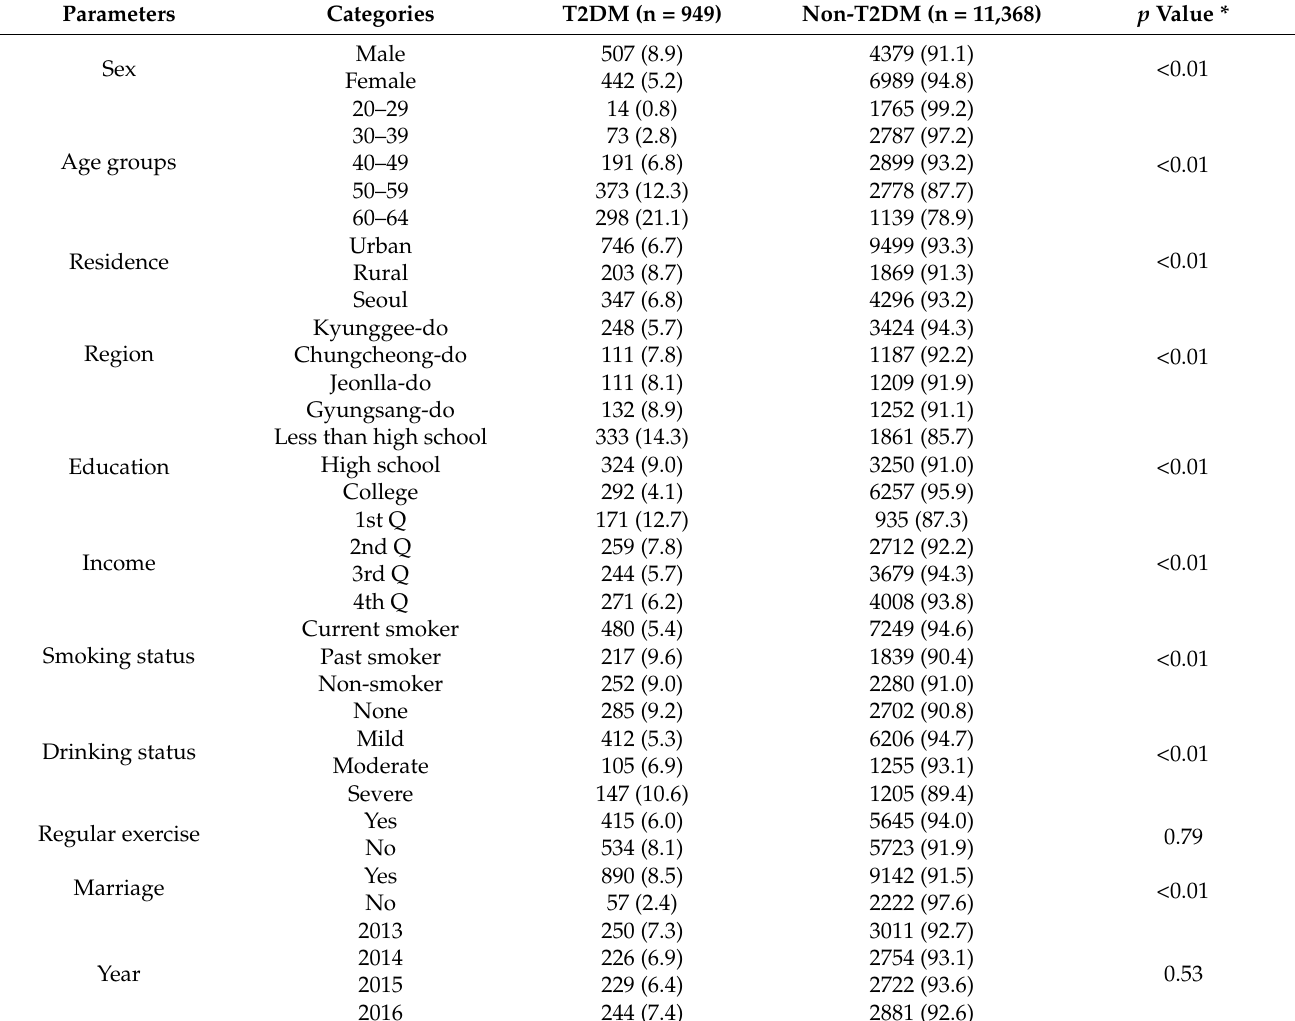
Table 1. Distribution of study population by diabetes according to socioeconomic and lifestyle